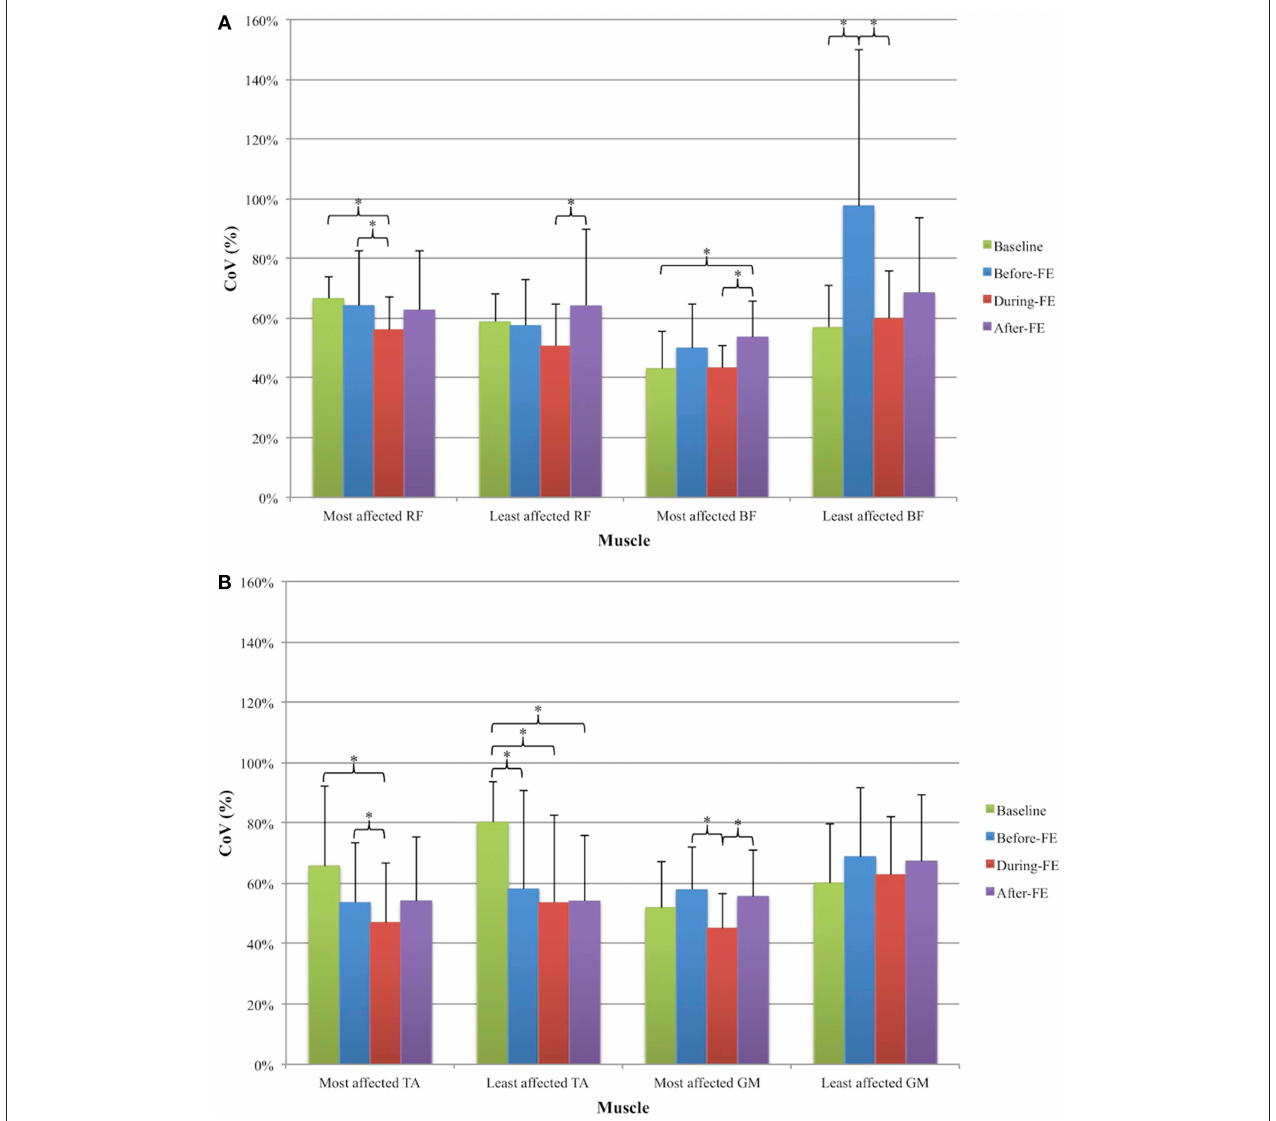
FIGURE 4 | Average ( + SD) coefficient of variation (CoV, expressed as percentage) of the (A) proximal leg muscles [most and least affected rectus femoris (RF) and biceps femoris (BF)] and (B) distal leg muscles [most and least affected tibialis anterior (TA) and gastrocnemius medialis (GM)] across four periods: Baseline, 2s before a freezing episode (Before-FE), during the freezing episode (During-FE), and 2s after a freezing episode (After-FE). *denotes significant pairwise differences ( p <